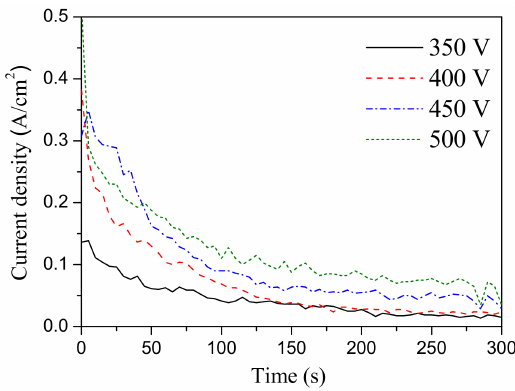
Figure 2. Current density with time of the micro-arc oxidation (MAO) process for deposition of CaP coatings on Mg alloy under different